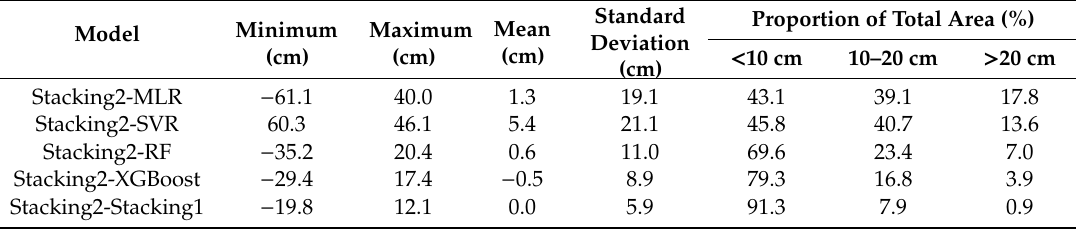
Figure 10. Spatial differences of the predicted soil thickness maps between the Stacking2 model and other models. Table 5. Descriptive statistics of differences of predicted soil thickness maps between the Stacking2 model and other models.